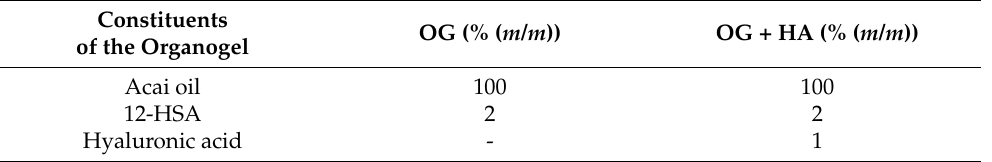
Table 4. Composition of the organogel of acai